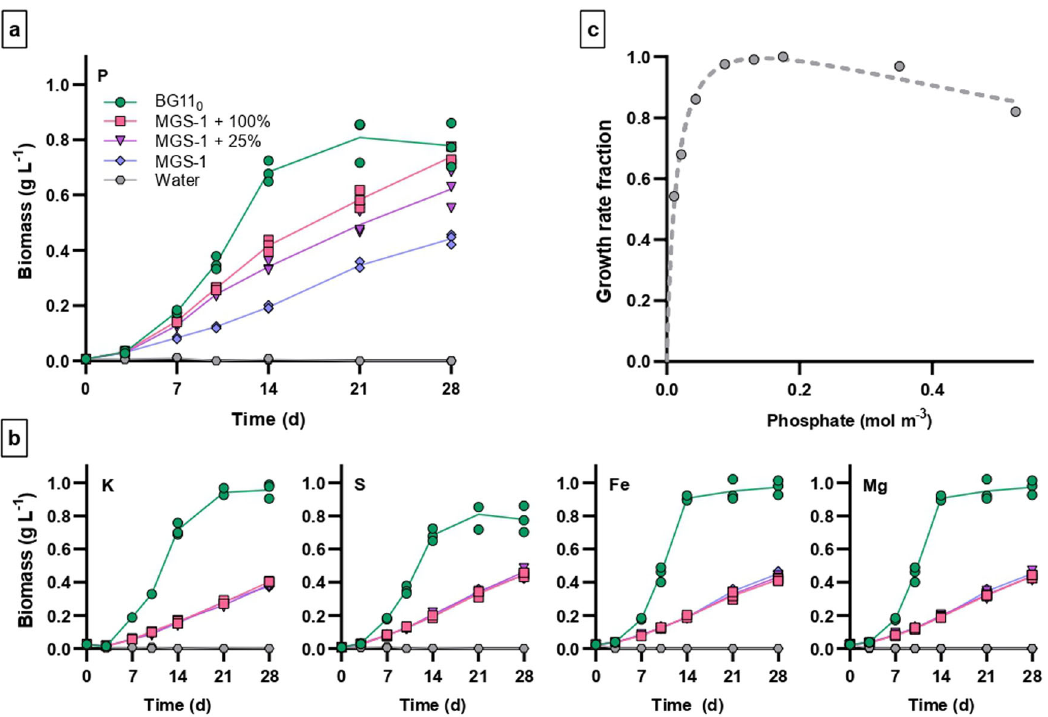
Fig. 3 Identi fi cation of the element which is limiting when Anabaena sp. PCC 7938 utilizes MGS-1 as a nutrient source. a , b Growth curves in BG11 0 (circles), in ddH 2 O (hexagons), or in ddH 2 O containing MGS-1, unsupplemented (diamonds) or supplemented with phosphorus (Na 2 HPO 4 ; P); potassium (KCl; K); sulfur (Na 2 SO 4 ; S); iron (FeCl 3 ; Fe) or magnesium (MgCl; Mg) at concentrations corresponding to those found in BG11 0 (squares) or a quarter of them (triangles). c Normalized growth rate in BG11 0 as a function of the concentration of phosphate (provided as Na 2 HPO 4 ).